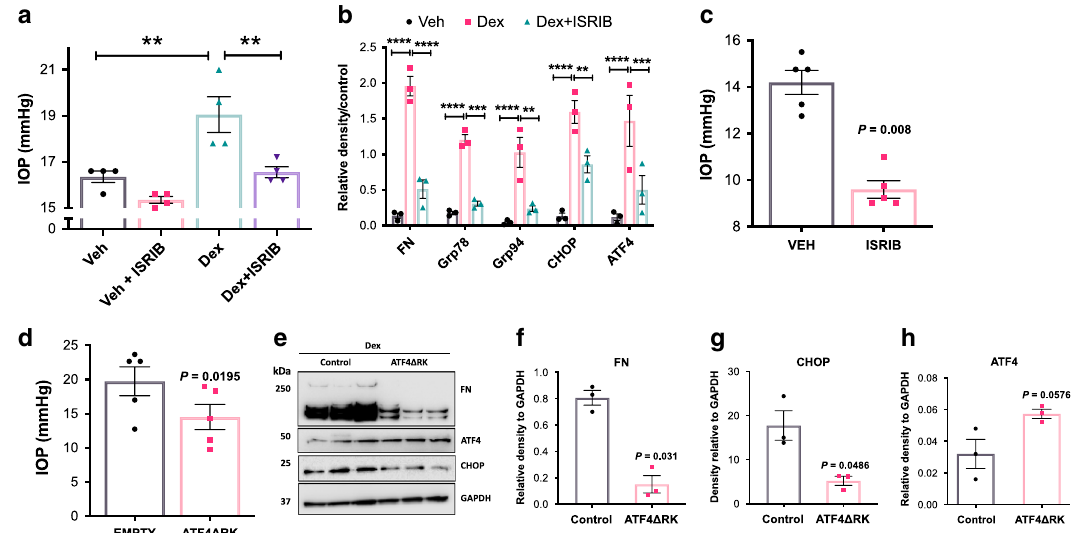
Fig. 7 Pharmacological inhibition of ATF4 rescues mouse models of glaucoma. a C57 mice were injected with vehicle ( n = 4) and Dex ( n = 4) weekly via periocular conjunctival fornix injections. After 2 weeks, left eyes received 5 µ l of 2 mM ISRIB topical eye drops while the contralateral right eyes received vehicle eye drops (DMSO) twice daily. One-week ISRIB treatment signi fi cantly lowered IOPs in Dex-injected left eyes compared to the contralateral right eyes ( n = 4 biologically independent samples; data are presented as mean ± SEM, one-way ANOVA, Tukey ’ s multiple comparison test, ** P < 0.01). b Western blot (Supplementary Fig. 21) and densitometric analysis b of mouse anterior segment lysates injected with vehicle or Dex for 2 weeks and treated with 5 µ l of 2 mM ISRIB topical eye drops or DMSO control. ISRIB treatment prevented Dex-induced FN and ER stress markers ( n = 3 biologically independent samples; data are presented as mean ± SEM, one-way ANOVA, ** P < 0.01, *** P < 0.001, **** P < 0.0001). c The ocular hypertensive Tg. MYOC Y437H mice received ISRIB eye drops in left eyes whereas the contralateral right eyes received vehicle (DMSO) eye drops twice daily. IOPs were recorded after one-week treatment ( n = 5 biologically independent samples; data are presented as mean ± SEM, two-tailed paired t -test). d C57 mice were treated with Dex for 3 weeks via periocular route. IOPs were measured after 3 weeks. After ocular hypertension was con fi rmed, Ad5.ATF4 Δ RK (2 × 10 7 pfu/eye) was injected intravitreally in the left eyes while the contralateral right eyes were injected with Ad5.Empty. Both eyes were treated with Dex for another week and IOPs were measured every week. Ad5.ATF4 Δ RK reduced elevated IOP compared to contralateral eyes injected with Ad5. empty ( n = 4 biologically independent samples; data are presented as mean ± SEM, two-tailed paired t -test). e – h Western blot e and its densitometric analyses f – h of mouse anterior segment lysates show that ATF4 Δ RK prevented Dex-induced fi bronectin and CHOP. n = 3 biologically independent samples; data are presented as mean ± SEM, two-tailed unpaired t